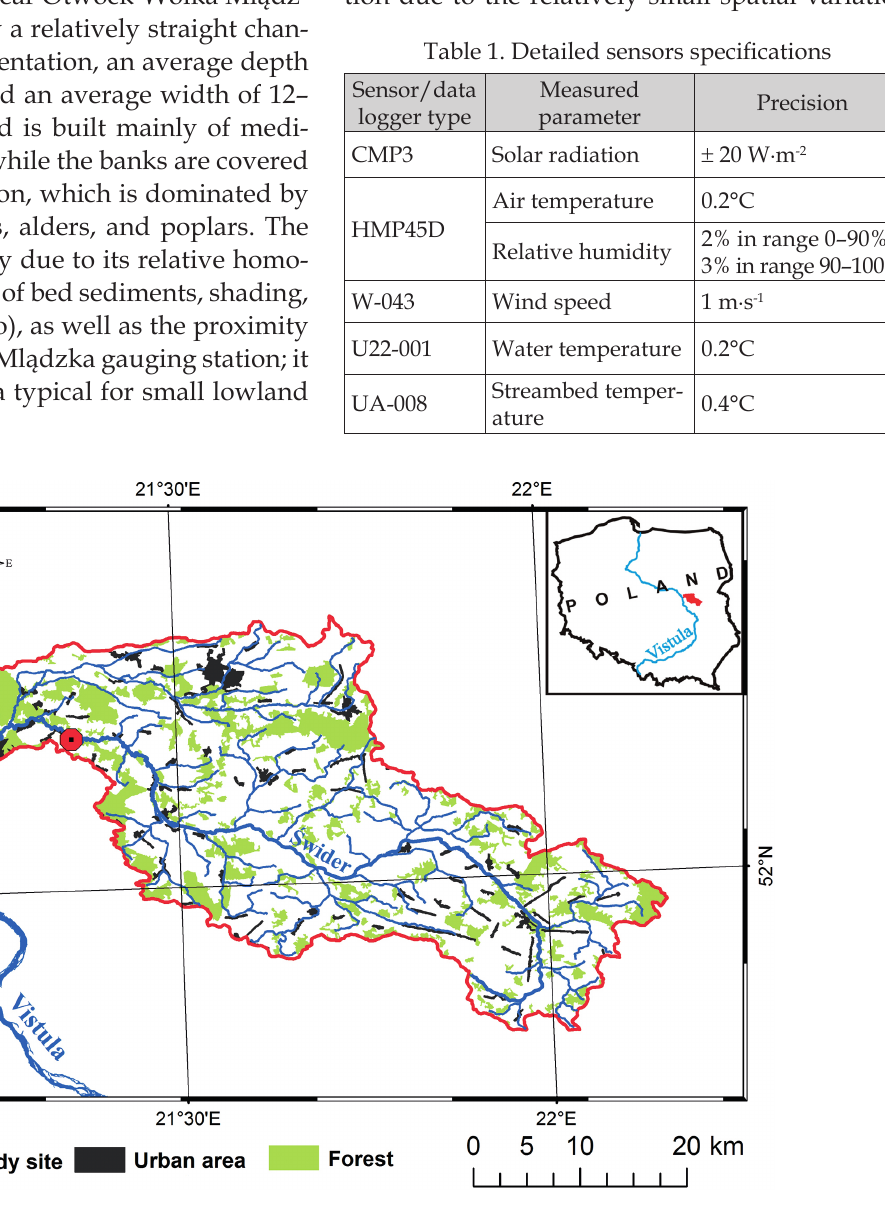
Fig. 1. River catchment and location of study